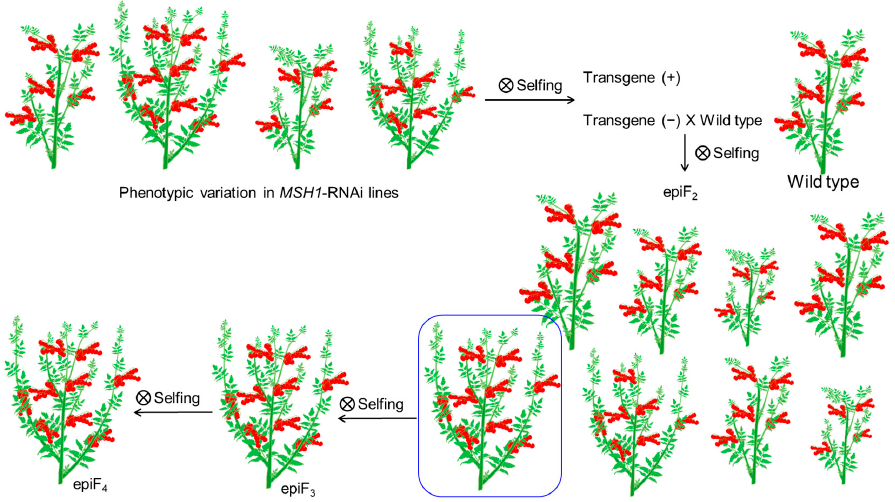
Figure 7. Epigenetic alteration of tomato phenotypes via MutS HOMOLOG 1 ( MSH1 ) suppression by RNA interference (RNAi). Transgene-null segregants derived from progeny of MSH1 -RNAi transgenic plant were crossed to wild-type line; some F 2 plants, which are termed epiF 2 , showed enhanced seedling growth and fruit yield relative to the wild type; and epiF 3 derived from single epiF 2 , which showed enhanced seedling growth and fruit yield, also showed higher yield than in the wild type.